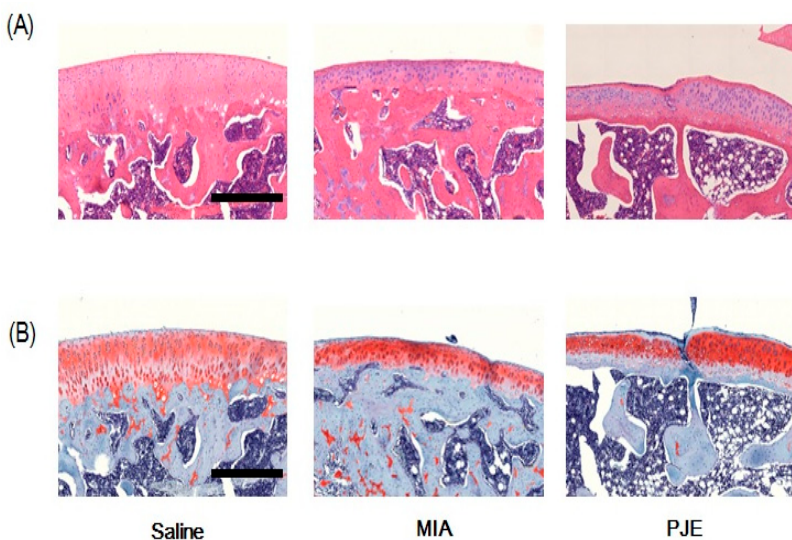
Figure 2. Histopathological features of knee joint tissue of MIA-induced OA model rats. Representative photographs of knee joint tissues stained with ( A ) hematoxylin and eosin, and ( B ) safranin O-fast green ( × 100 magnification). Scale bars = 500 µ m.